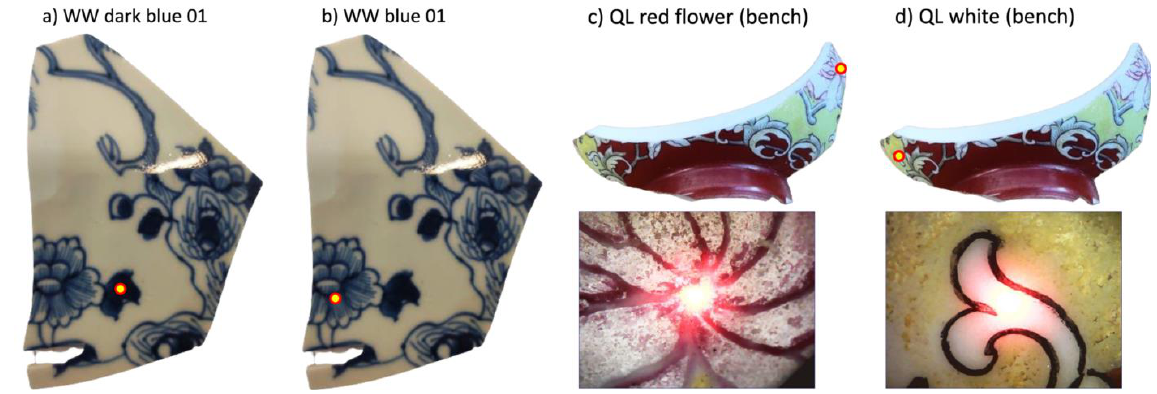
Figure 3. Differences between the dark blue ( a ) and the blue ( b ) areas analyzed on sample ww. Red flower enamel ( c ) and white one ( d ) analyzed on sample QL (yellow dots: analyzed area).